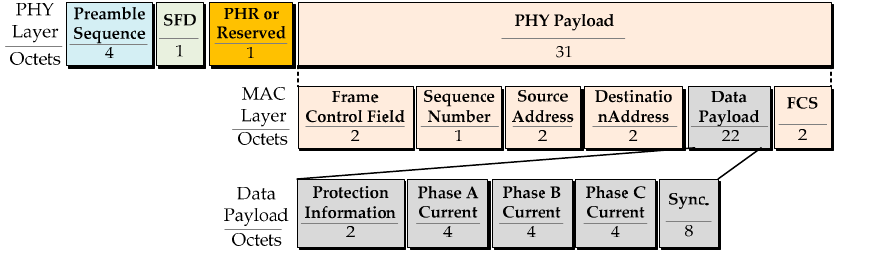
Figure 4. WSN data packet frame.